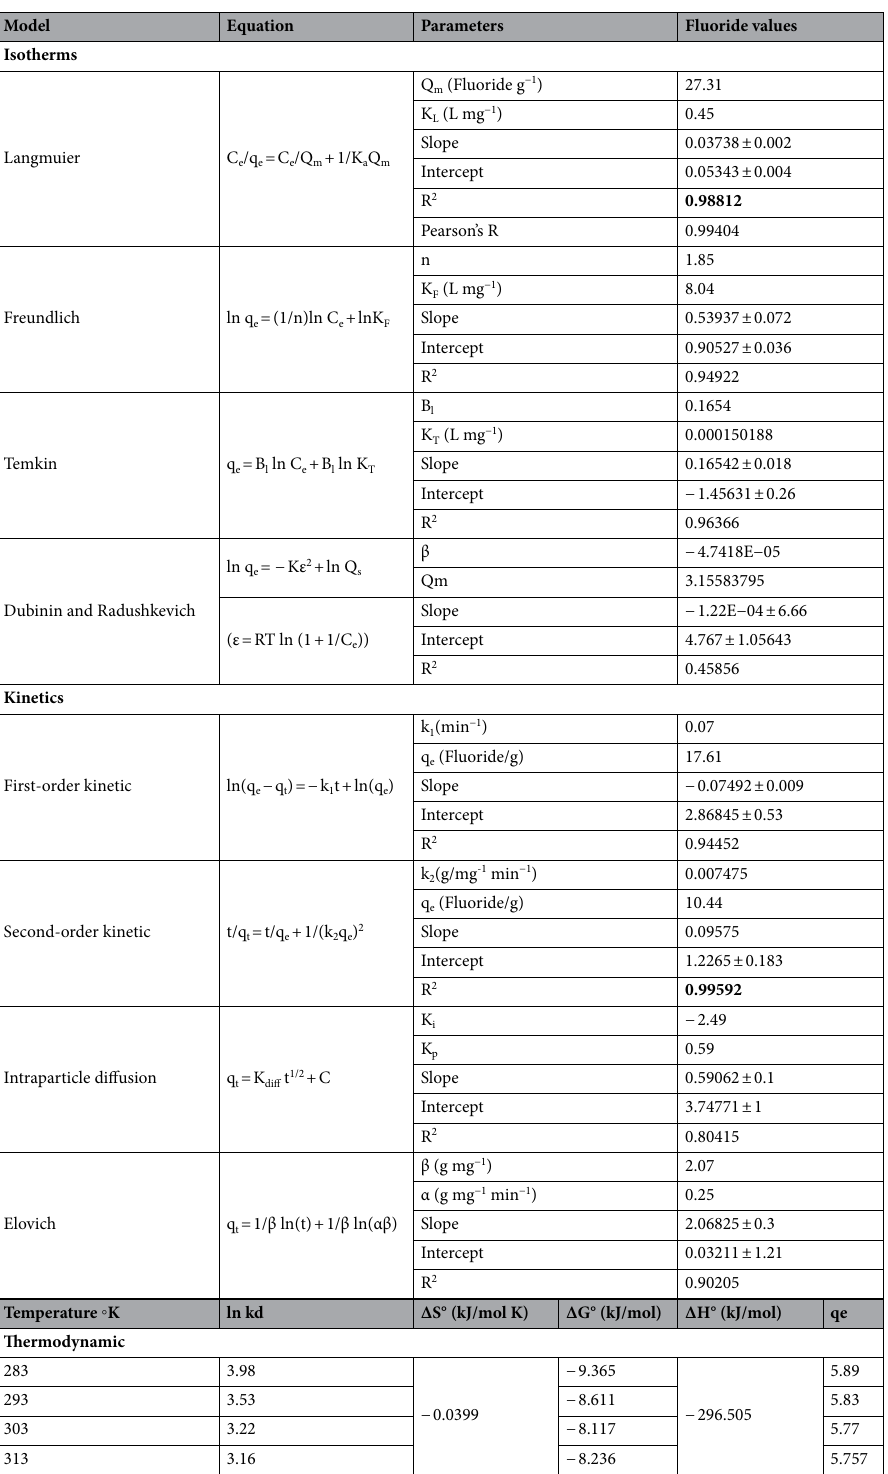
Table 3. Isotherm, kinetic, and thermodynamic parameters for fluoride adsorption into bivalve shell under the optimized condition. Significant values are in